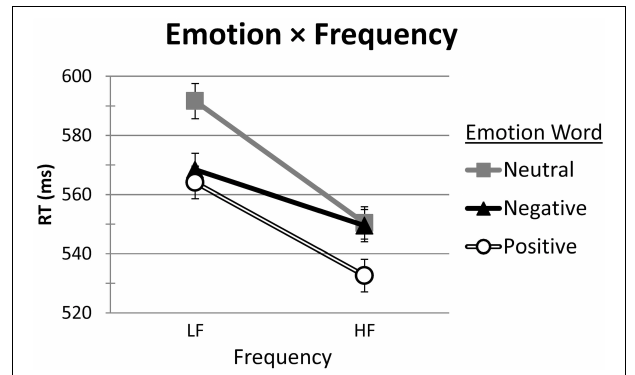
FIGURE 4 | Mean RT (ms), with SE bars, on words as a function of Mood (Control, Positive, Negative) and Emotion (Positive, Negative,